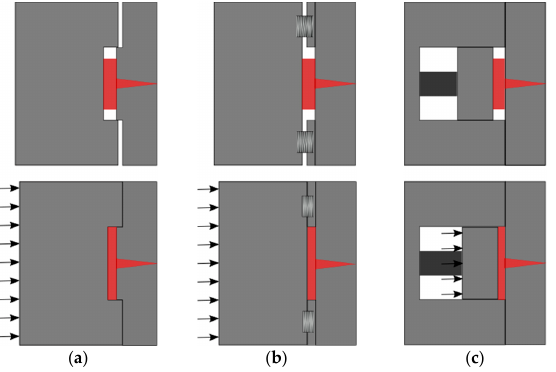
Figure 1. Different injection compression molding (ICM) mold closures before (upper picture) and during compression (lower picture), and their schematic architectures: ( a ) generating a “vertical flash” area; ( b ) using a spring-connected “compression-frame”; ( c ) adopting an actuated compression